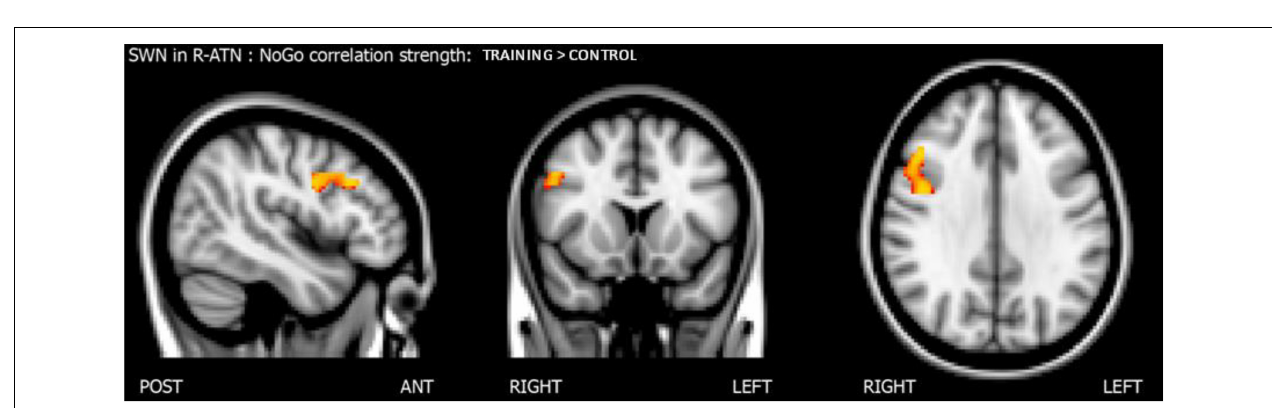
FIGURE 3 | Scatter plot of individual parameters estimate (PE) of functional connectivity evolution in the training and control groups within R-ATN (right) and L-ATN (left) .